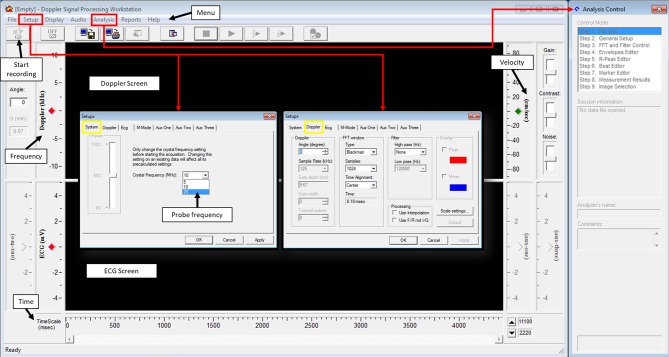
Doppler signal processing workstation user's interphase.